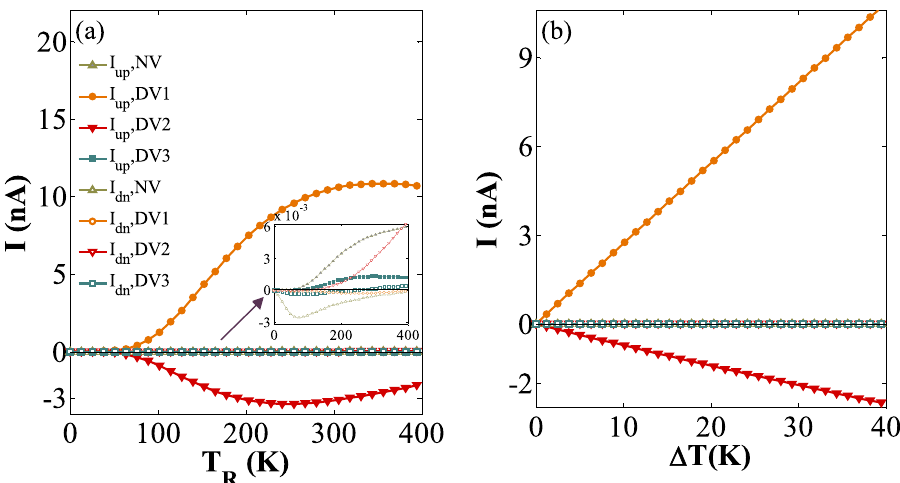
Figure 6. ( a ) I up and I dn versus T R for ∆ T = 40 K; ( b ) I up and I dn versus ∆ T for T R = 350 K and NV, DV1, DV2, and DV3 configurations, respectively.